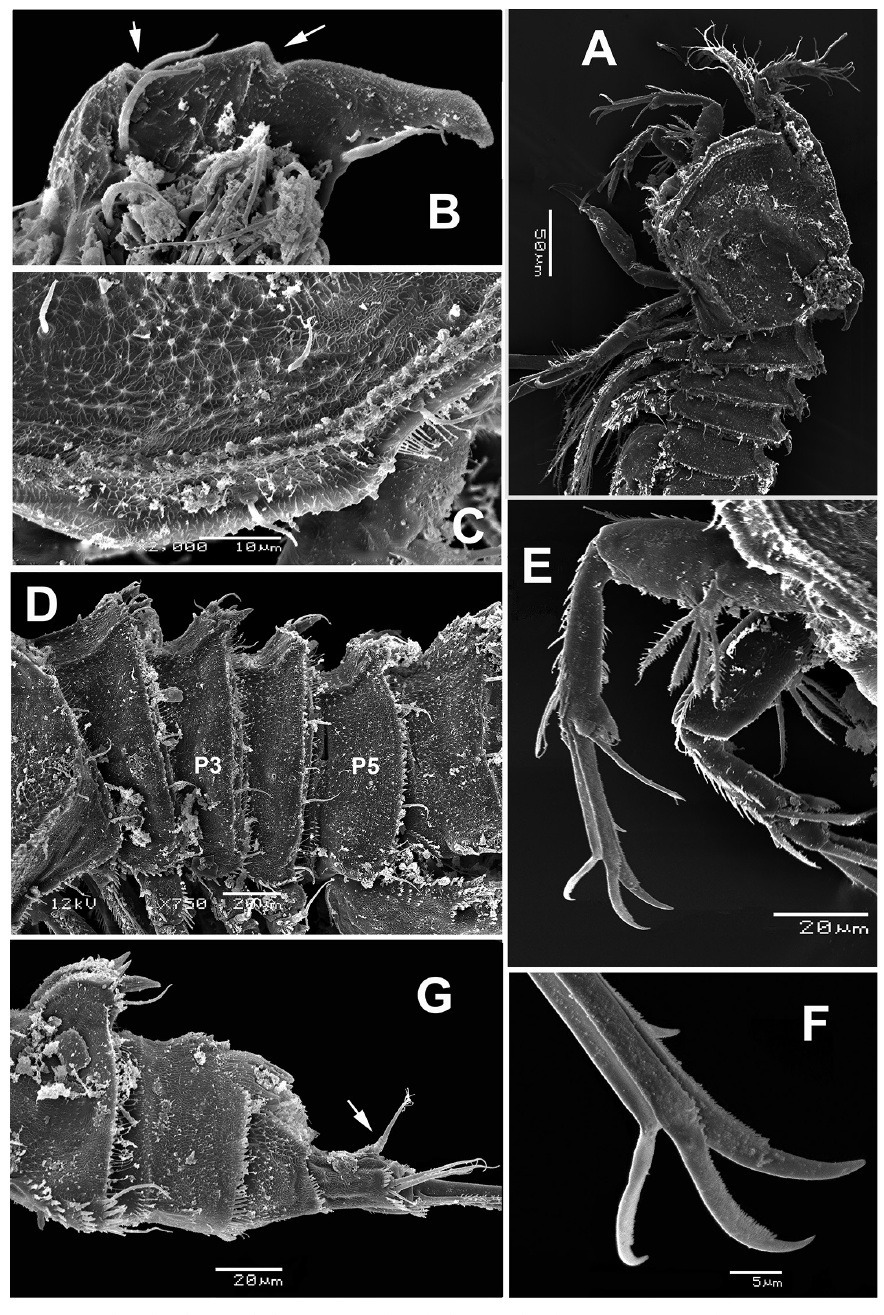
Figure 5. Echinolaophonte villabonae sp. n., female from Colombia, SEM-prepared specimen. A cepha- lothorax, lateral view B dorsal process on cephalic shield showing distinctive notches (arrowed) C detail of cephalic shield marginal ornamentation D pedigerous somites 2–5, lateral view E antenna F detail of distal elements of antenna G urosome and caudal rami, lateral view, caudal seta VII